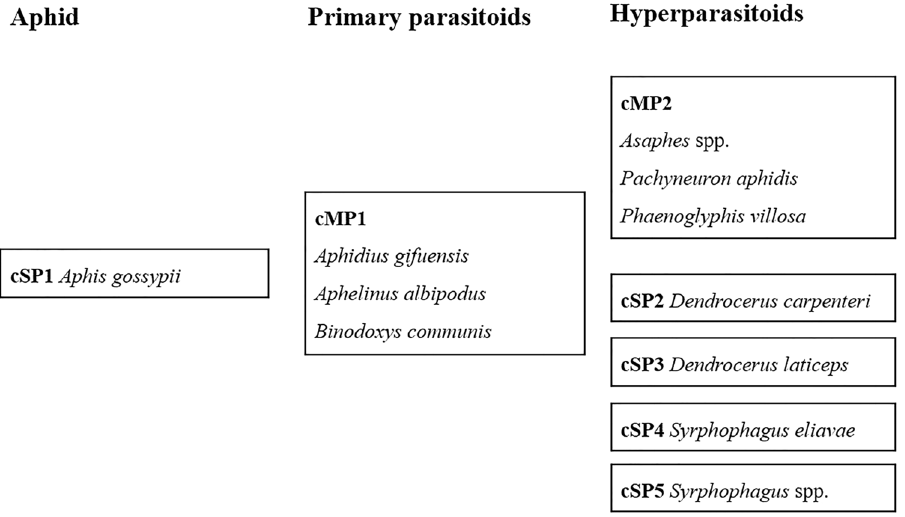
Figure 1. Composition of the cotton multiplex PCR detection system and the aphid and parasitoid species detected in each